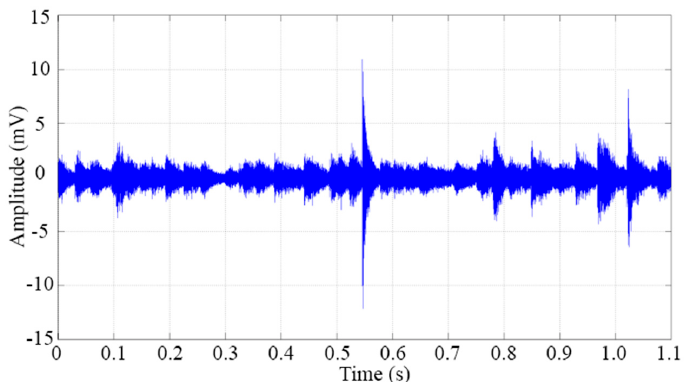
Figure 23. AE signals received during the diagnosis of shafts. The beginning of the destruction of the shaft surface during frictional contact.